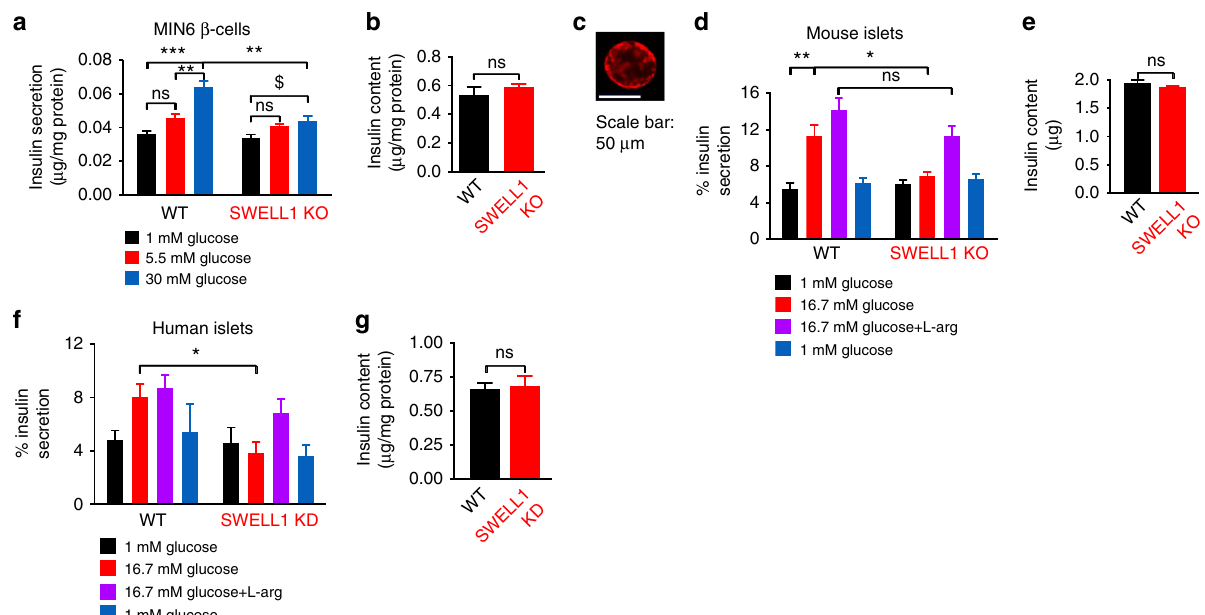
Fig. 7 β -cell SWELL1 is required for glucose-stimulated insulin secretion in vitro. a Glucose-stimulated insulin secretion (GSIS) in WT and Swell1 KO MIN6 cells in response to 1, 5.5, and 30 mM glucose ( n = 3, each). b Total insulin content normalized to total MIN6 cell protein content ( n = 3, each). c Representative image of Ad-RIP1-Cre-RFP-transduced mouse islet. Scale bar represents 50 µ m. d GSIS in WT (Ad-RIP1-RFP/ Swell1 fl / fl ) and β -cell-targeted SWELL1 KO (Ad-RIP1-Cre-RFP/ Swell1 fl / fl ) islets. Insulin secretion is expressed as percentage of the total insulin content ( n = 4, each). e Total insulin content of WT and β -cell-targeted Swell1 KO islets ( n = 4, each). f GSIS in human WT and SWELL1 KD islets. Insulin secretion is expressed as percentage of the total insulin content ( n = 4, each). g Total insulin content of WT and SWELL1 KD islets ( n = 4, each). Data are shown as mean ± s.e.m. One-way ANOVA for in-group comparison, unpaired t -test for between-group comparison. * p < 0.05, ** p < 0.01, *** p < 0.001. ns, not signi fi